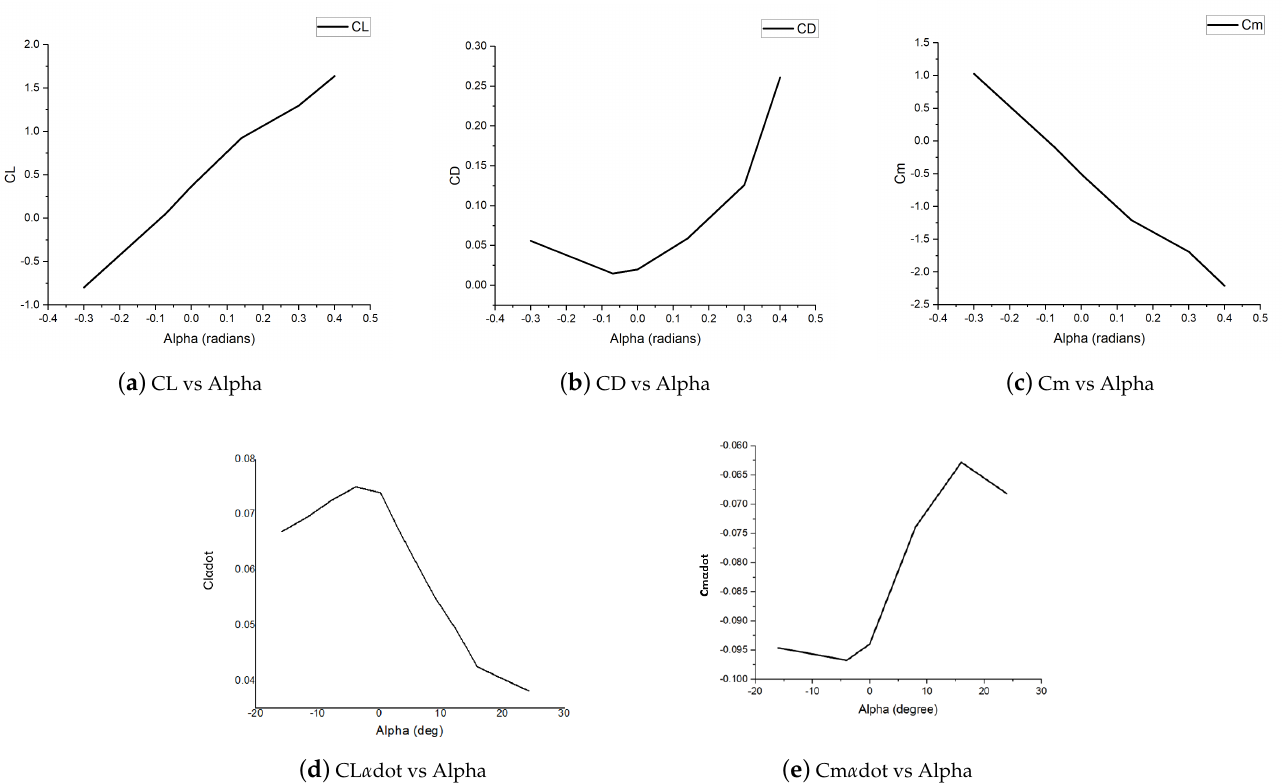
Figure 5. Analysis of longitudinal aerodynamic coefficients for different angle of attack ( a ) Variation of lift coefficient (CL) vs. angle of attack (Alpha) obtained using US DATCOM; the figure shows an increase in the lift with angle of attack until the stall angle is reached. ( b ) Variation of drag coefficient (CD) vs. angle of attack (Alpha) obtained using US DATCOM; the figure shows a decrease in drag at a negative angle of attack regime and then increase. ( c ) Variation of moment coefficient (Cm) vs. angle of attack (Alpha); the figure shows a negative slope in the curve with positive y-intercept fulfilling the longitudinal stability requirements. ( d ) Variation of CL α dot obtained using US DATCOM; the figure shows an increase and then decrease in lift coefficient with the rate of change of angle of attack. ( e ) Variation of Cm α dot obtained using US DATCOM; the figure shows the variation of the pitching moment coefficient due to the rate of change of angle of attack. The trends are similar to Boeing 737 commercial